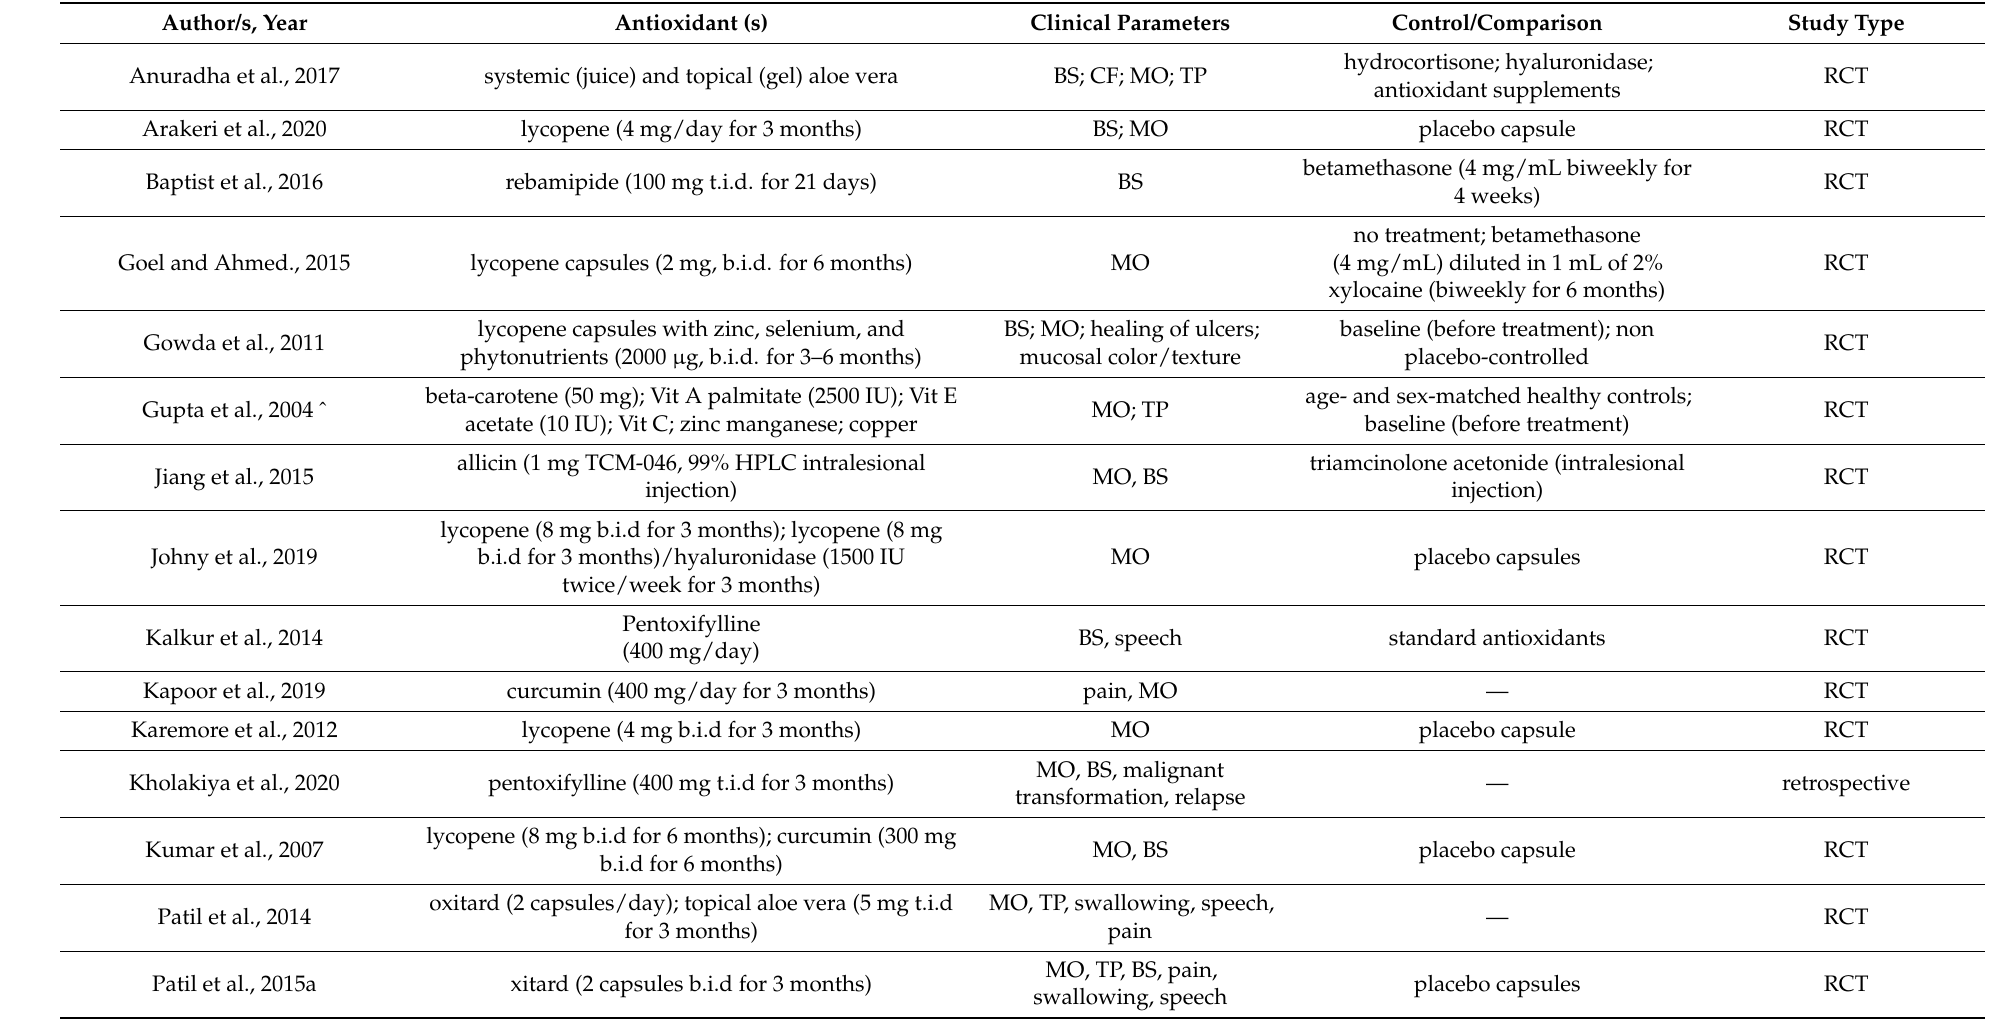
Table 2. Overview of clinical intervention studies that were eligible for